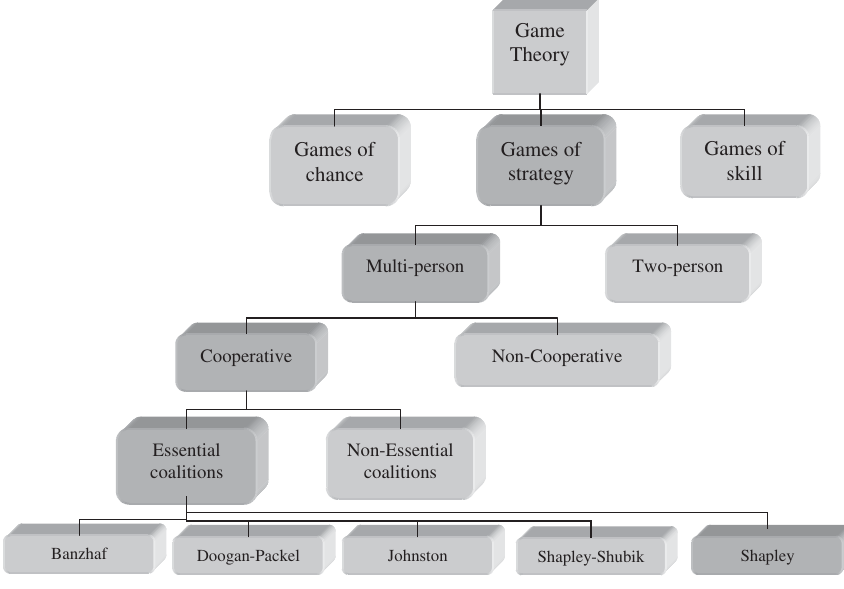
Fig. 2. A general game